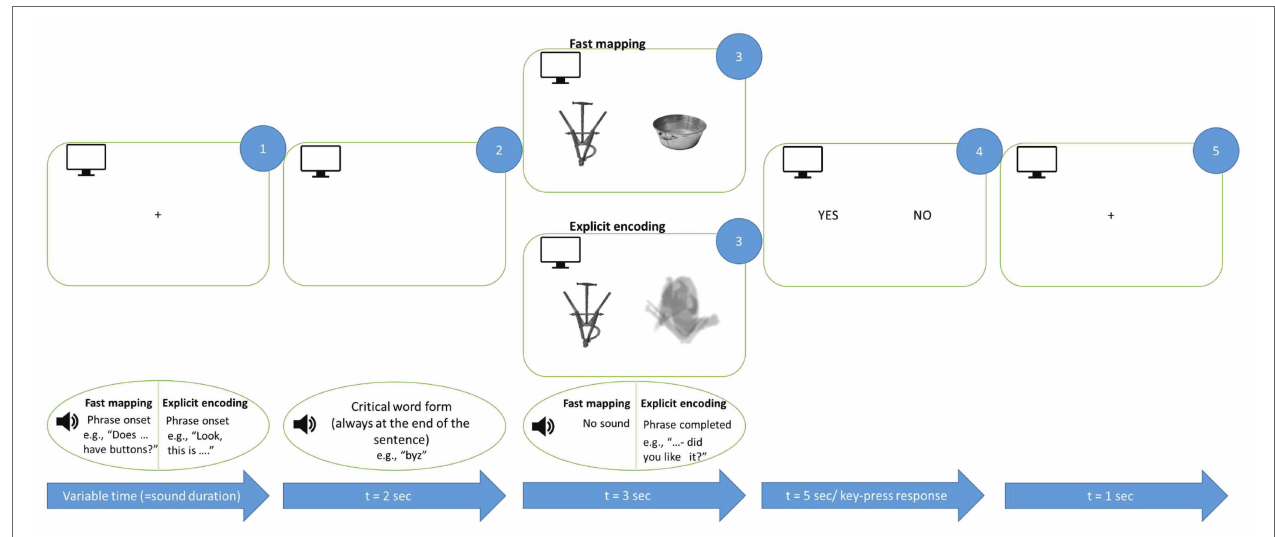
FIGURE 2 | Schematic illustration of FM and EE learning trials. Auditorily presented sentences were accompanied by graphically presented objects corresponding to new words. The critical word was always the last auditory stimulus before the image onset (see Materials and Methods). Both EE and FM conditions included a question and were maximally matched for their overall properties. Note that English examples are given for illustration only, the original sentences were produced in accordance with Russian